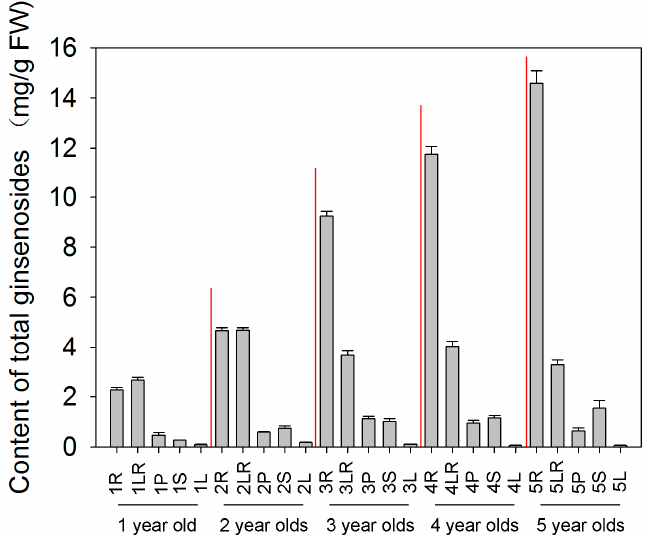
Figure 1. Total ginsenosides analysis of ginseng at five developmental stages and five tissues. Ginseng samples of five developmental stages 1-, 2-, 3-, 4- and 5-year old were collected for ginsenosides analysis by UPLC-MS. The data represent the mean ± standard error of the mean values for six biological replications.